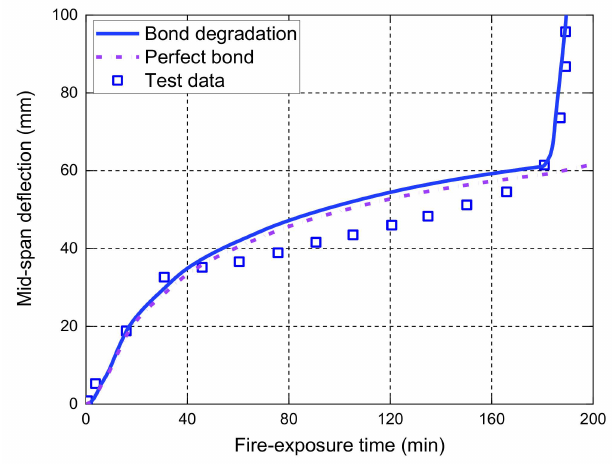
Figure 7. Measured deflections versus FE predictions of slab